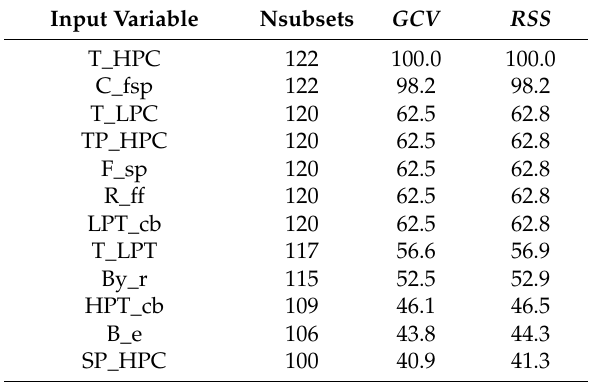
Table 4. Significance ranking for the variables involved in the best fitted ABC–MARS-based model for the RUL prediction according to criteria Nsubsets, GCV and RSS.